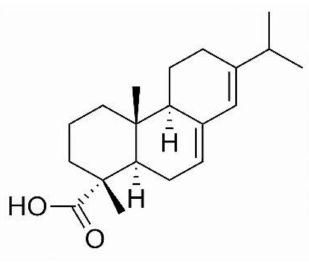
Figure 5. Molecular composition of the abietic